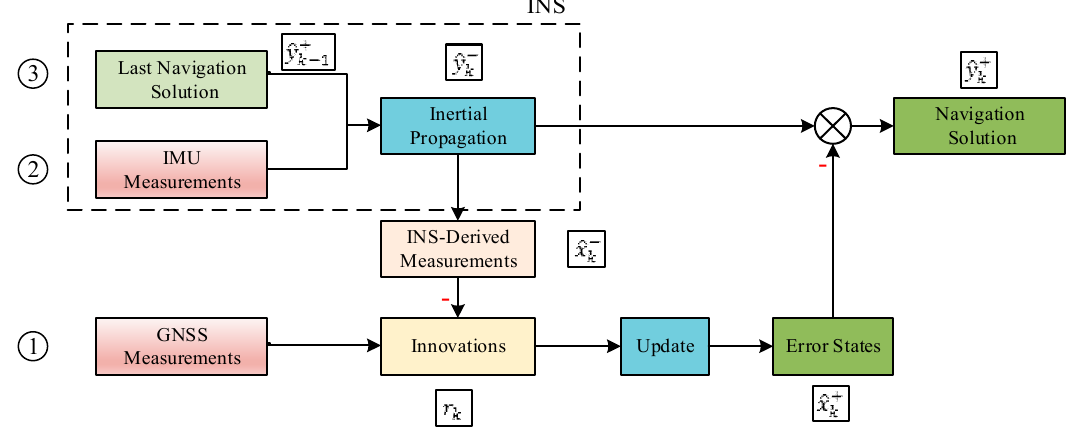
Figure 2. Prediction process and update process in the integrated system. (Note, 𝑥 —error states, and 𝑦 —absolute states).